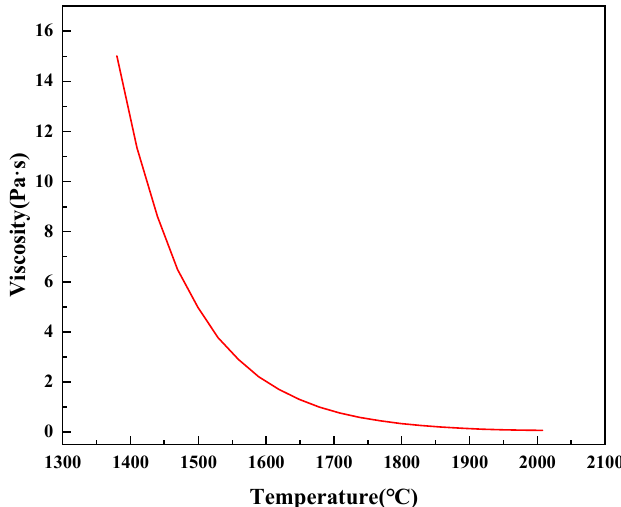
Figure 3. Visco-temperature curve of magnesium slag.